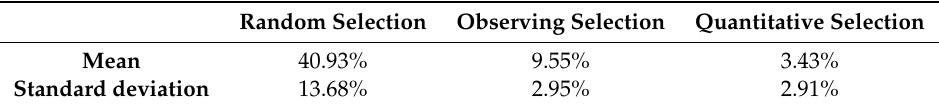
Figure 12. Anomaly detection for sensor data set 4 with GPR for the observing sensor selection. For the quantitative sensor selection strategy, the four values of FPR are 2.08%, 2.23%, 1.64%, and 7.79%, respectively. For the observing sensor selection strategy, the four values of FPR are 12.50%, 5.59%, 9.29%, and 10.82%, respectively. In the above mentioned data sets, four pairs of sensor data are selected randomly to implement the data anomaly detection. The values of FPR are 32.81%, 50.84%, 54.10%, and 25.97%, respectively. To compare the performance of three types of data anomaly detection, the mean and standard deviation of FPR are calculated, as illustrated in Table 12. Table 12. Mean and standard deviation of three selection